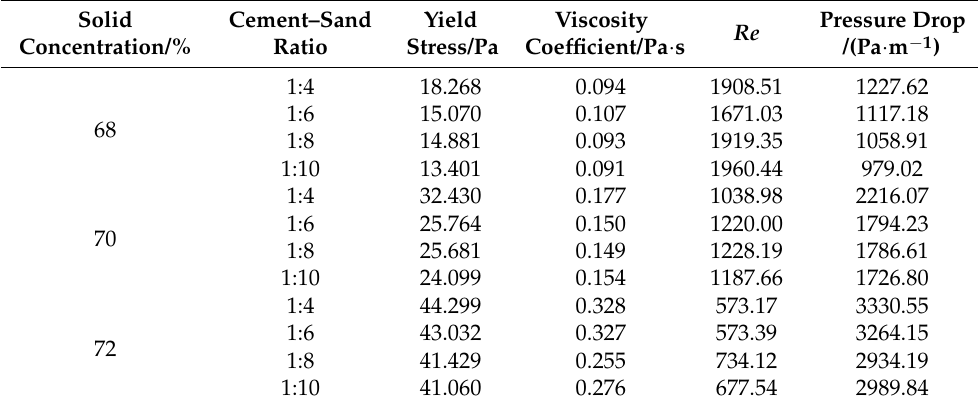
Table 5. R e and pressure drop of the slurry at a pipe diameter of 100 mm, velocity of 1.0 m/s.